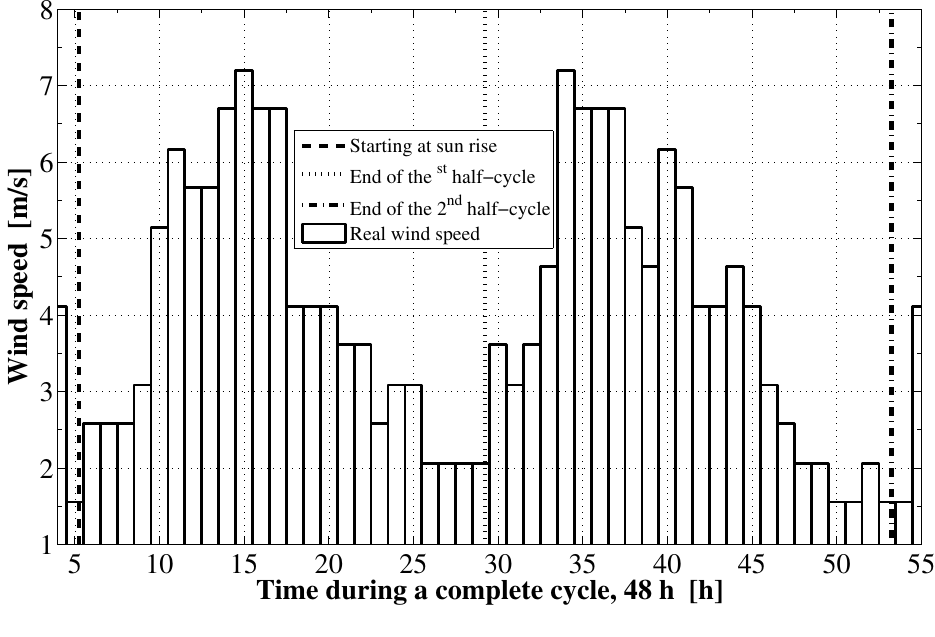
Figure 3. Records of the wind velocity during the cycle, as reported by the King Khaled International Airport weather station OERK in Riyadh, 1 July 2013 to 3 July